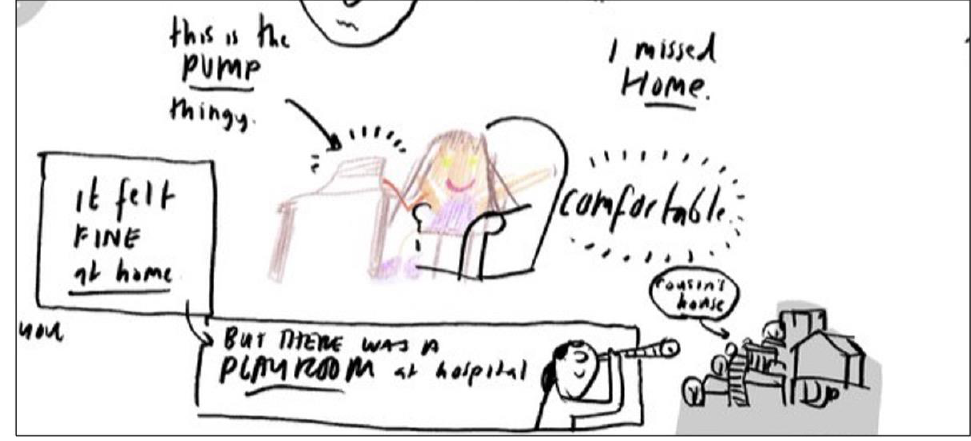
Figure 6. Child ’ s drawing integrated into the illustration developed during the consultation activity .